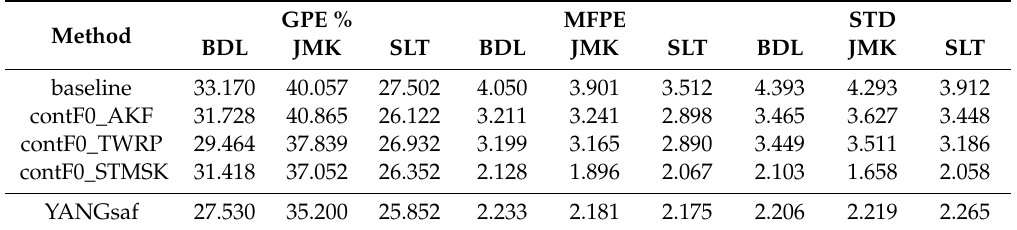
Table 2. Average performance score per each speaker in the presence of additive white noise (SNR = 0 dB).